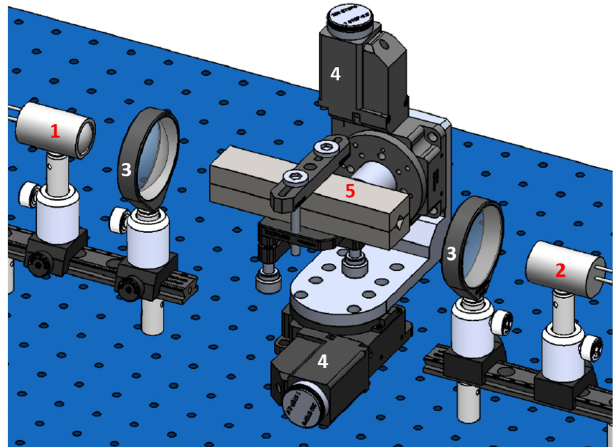
FIG. 11. Sketch of the opto-mechanical setup utilized for the measurements: (1) emitter, (2) detector, (3) TPX collimating lenses, (4) micrometric alignment systems, (5) DUT (waveguide).